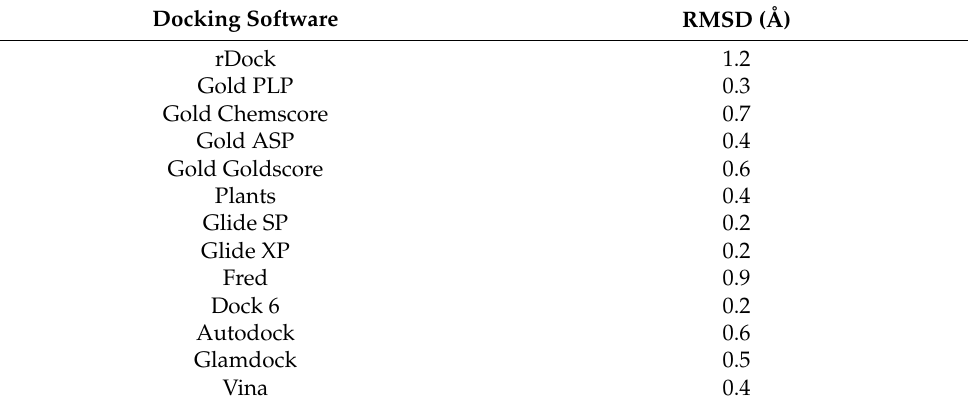
Table 1. RMSD results obtained with self-docking